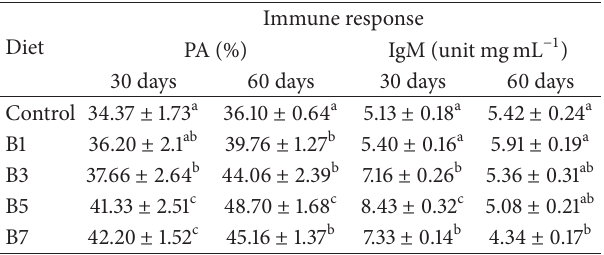
Table 5: Phagocytic activity (PA) and immunoglobulin (IgM) activities observed on different sampling days after feeding Labeo rohita with banana peel flour (BPF) supplemented diets.